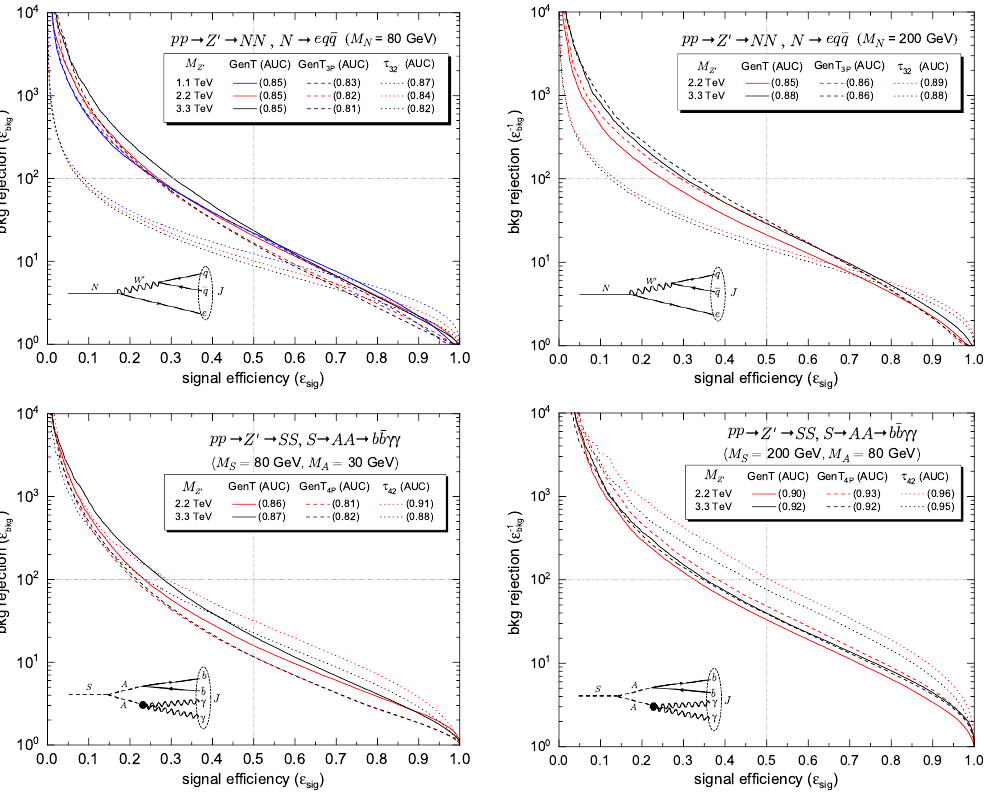
Figure 6 . ROC curves for other complex jet signals (for details see the self-explanatory legends and the main